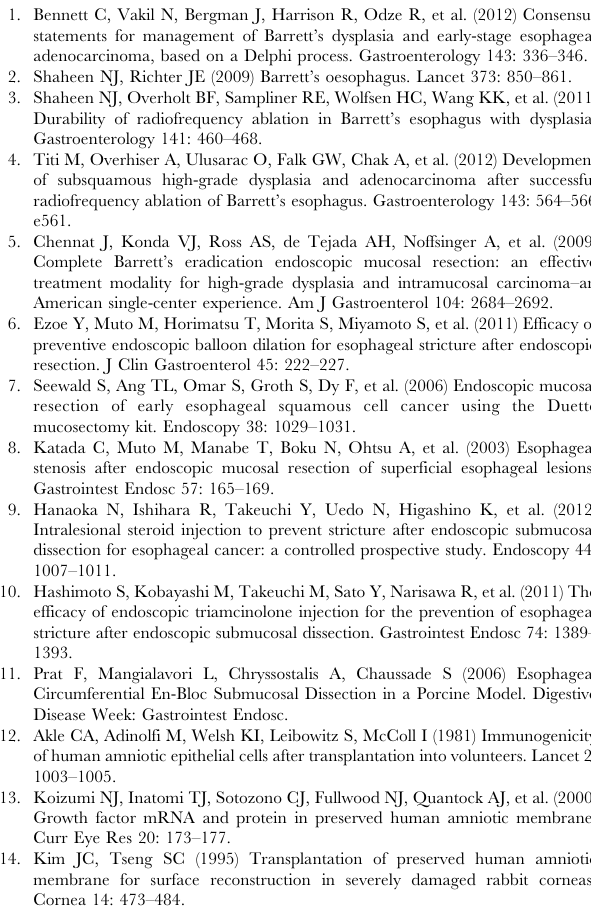
Figure 5. Oxidative stress markers measurements in tissue samples of strictured or normal esophagus; performed in control, AM1 and AM 2